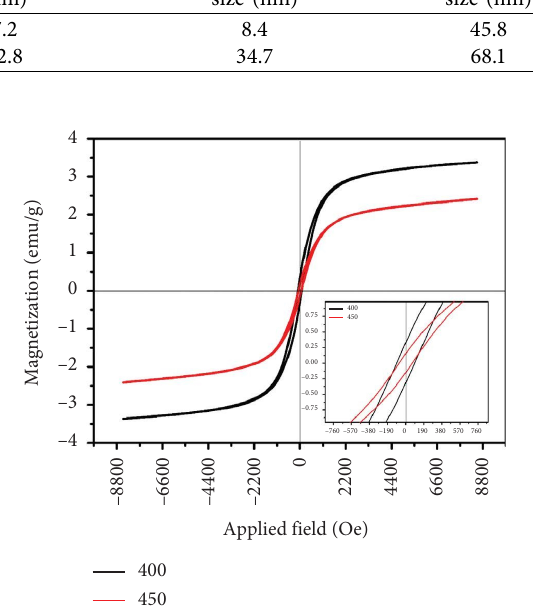
Figure 4: Variations of the magnetization with respect to applied magnetic feld of the samples heated at 400 and 450 ° C. Inset shows the low feld part of the